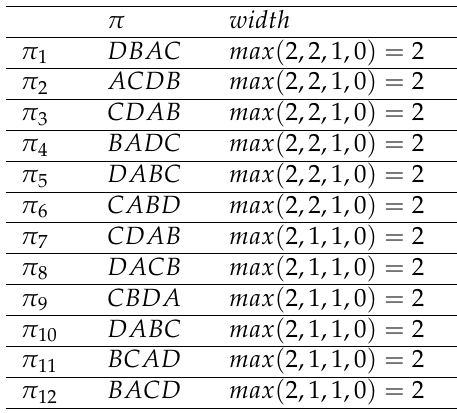
Table 1. The width in different elimination